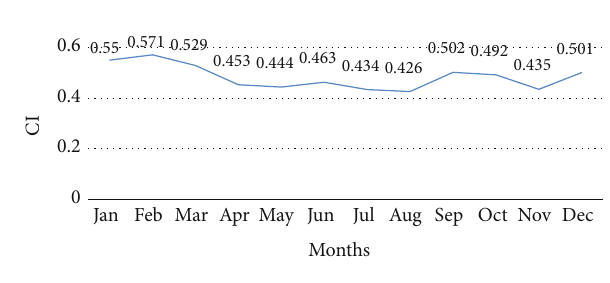
Figure 17: Monthly clearness index (CI) for Kenya.